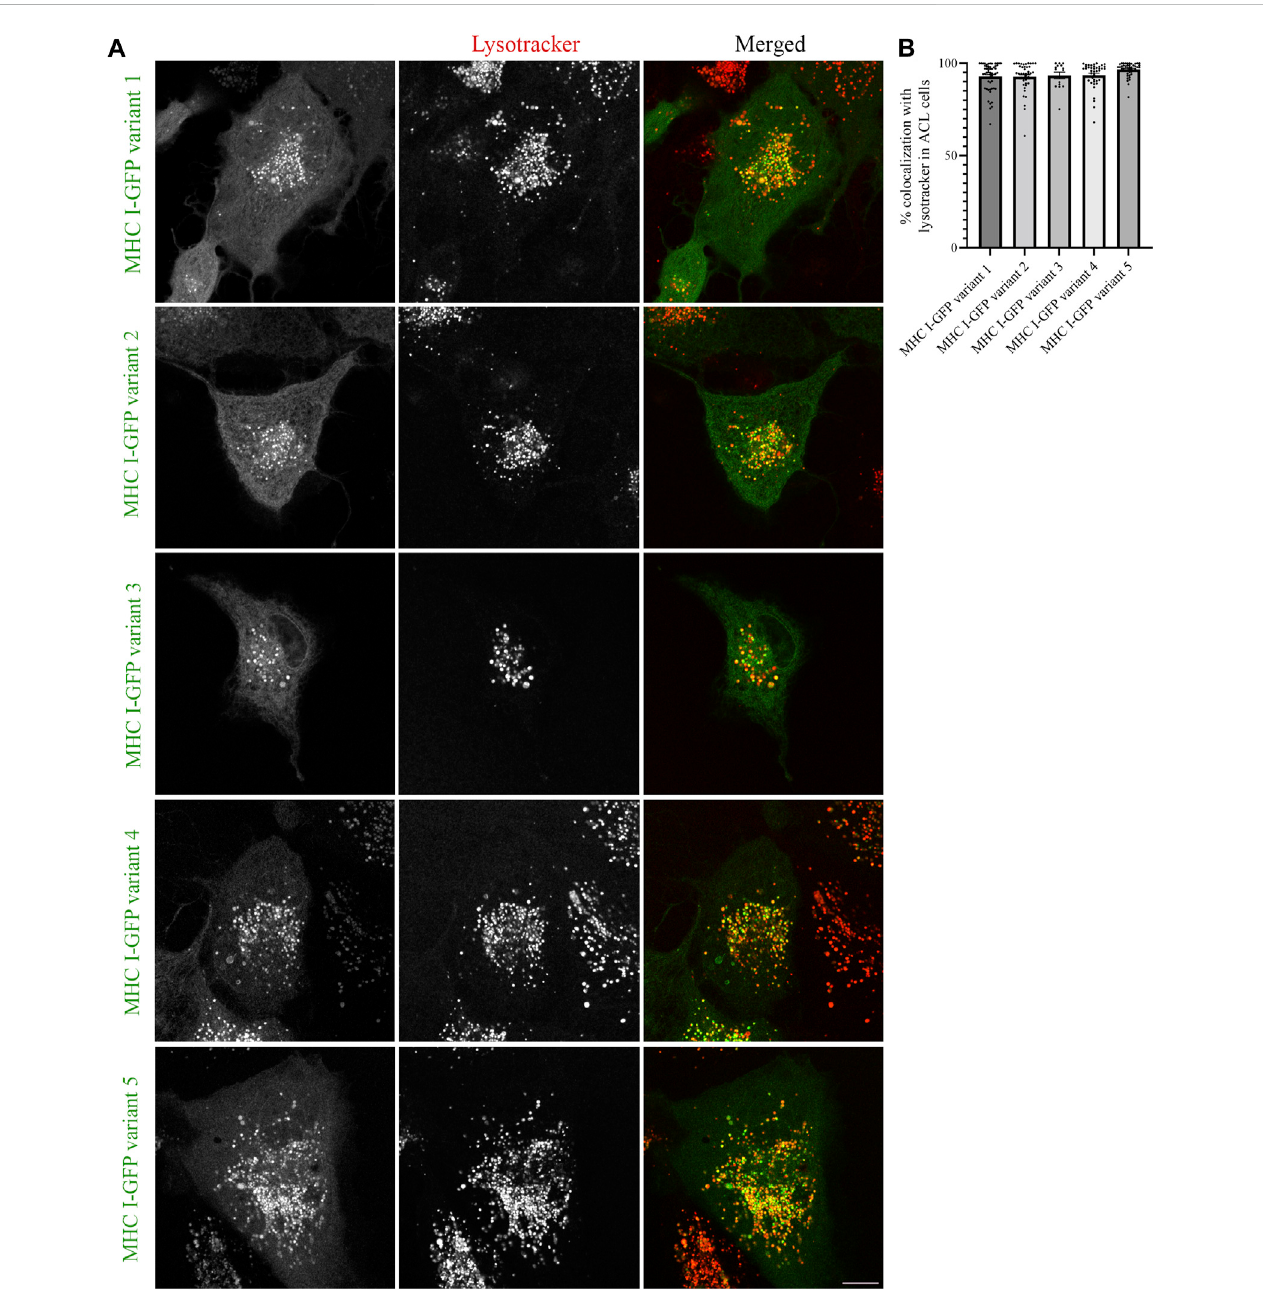
FIGURE 4 Intracellular localization of fi ve Atlantic cod MHC I variants in ACL cells. (A) Representative images of ACL cells transiently transfected with fi ve selected Atlantic cod MHC I-GFP variants (green). The cells were stained with lysotracker red and imaged using a Zeiss LSM880 Fast AiryScan microscope. Colocalization between green and red channels results in yellow signal in the merged panels. Scale bar: 10 μ m. (B) The graph represents the percentage of colocalization between Atlantic cod MHC I variant 1 – 5 and Lysotracker Red. Colocalization was done by object-based analysis using ImageJ software. Values represent the mean ± s.e.m. from at least three independent experiments. n ≥ 15 cells. Non-signi fi cant (Two-tailed paired Student t